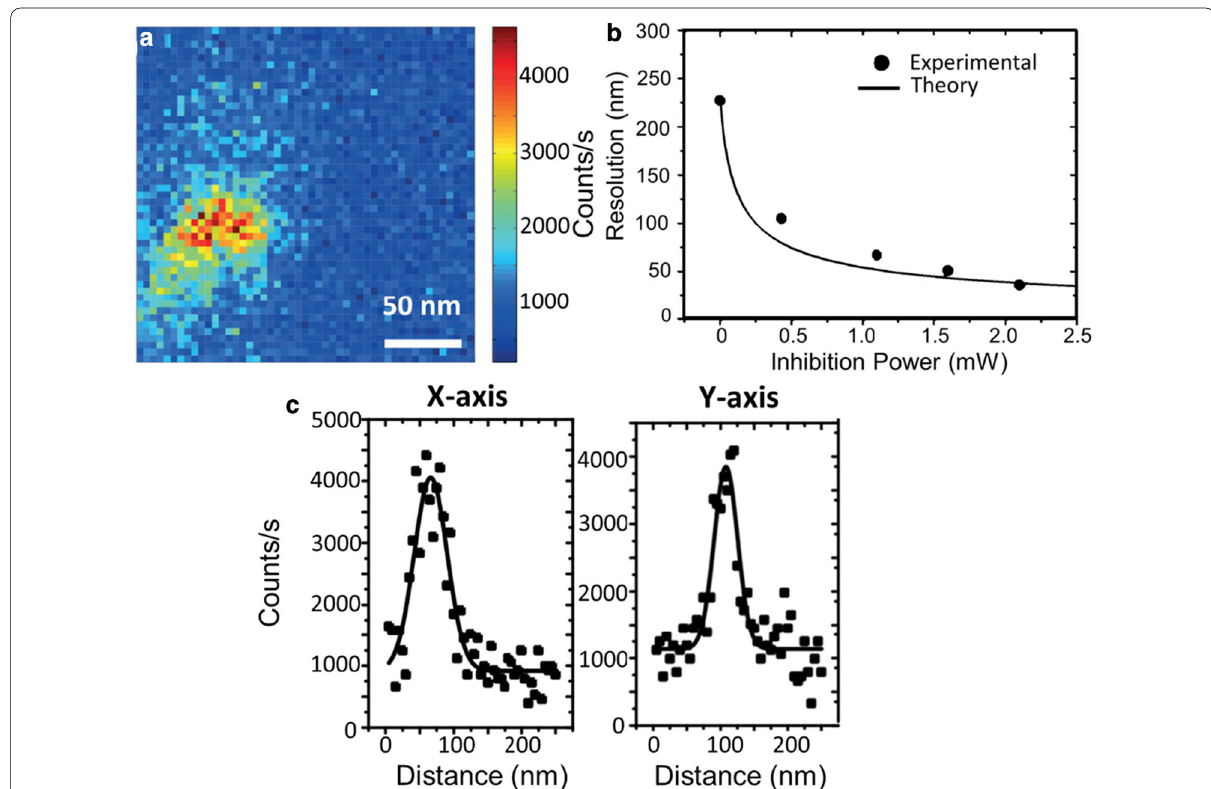
Fig. 3 a Fluorescence image of a super-resolved NV − centre based on GSD nanoscopy. Dwell time 10 ms and 2 nm pixel size. b Transverse resolution as a function of depletion power. The discrepancy between experiment and theory is most likely due to imperfections in the host material and changes in the local environment of NDs compared to bulk diamond. The theory is based on NV centres in bulk diamond. c Image cross sections profile along the x-axis and y-axis with a FWHM resolution of 57 nm and 42 nm, respectively. The solid line represents the best